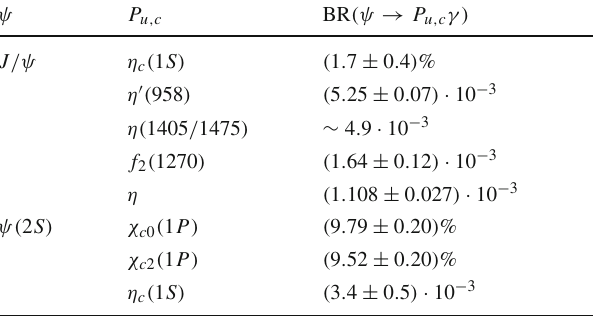
Fig. 4 Feynman diagrams of the processes ψ → P c γ → gg γ → (cid:3)(cid:4) 0 + c.c. and ψ → gg γ → P γ → (cid:3)(cid:4) 0 + c.c. representing u the dominant gg γ -isospin-violating contributions to the decay ψ → (cid:3)(cid:4) 0 + c.c.